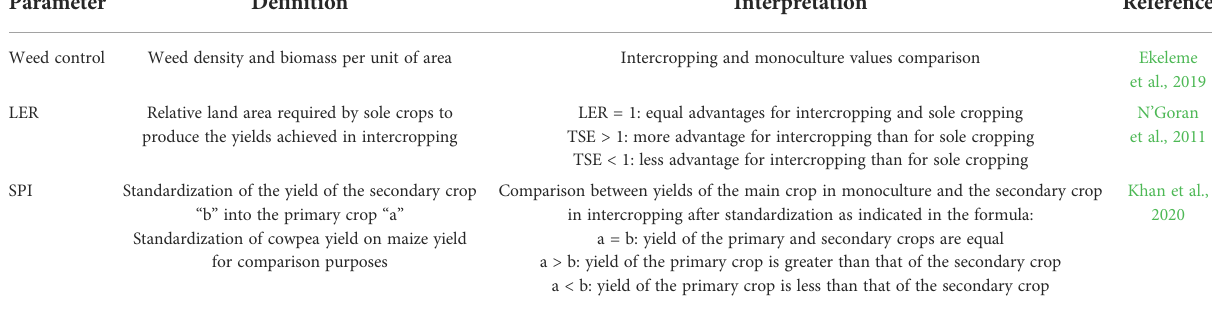
TABLE 3 Characteristics of the parameters for evaluating the ef fi ciency of the crop